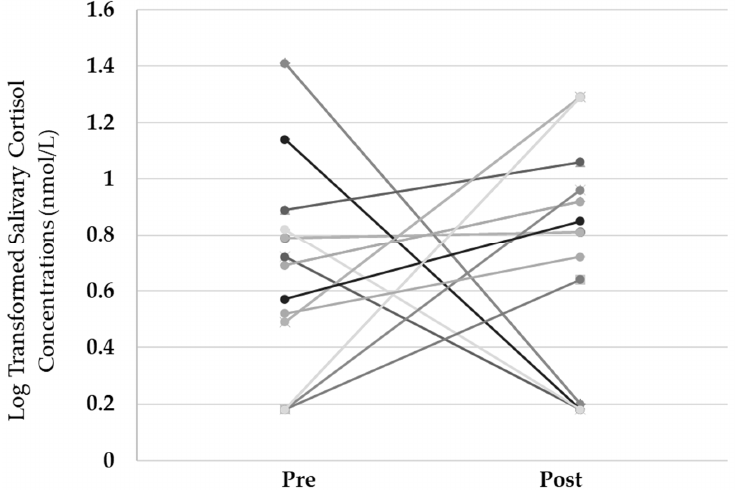
Figure A2. Plot showing changes in salivary cortisol concentrations pre- and post-participation in spring goose harvesting activities.